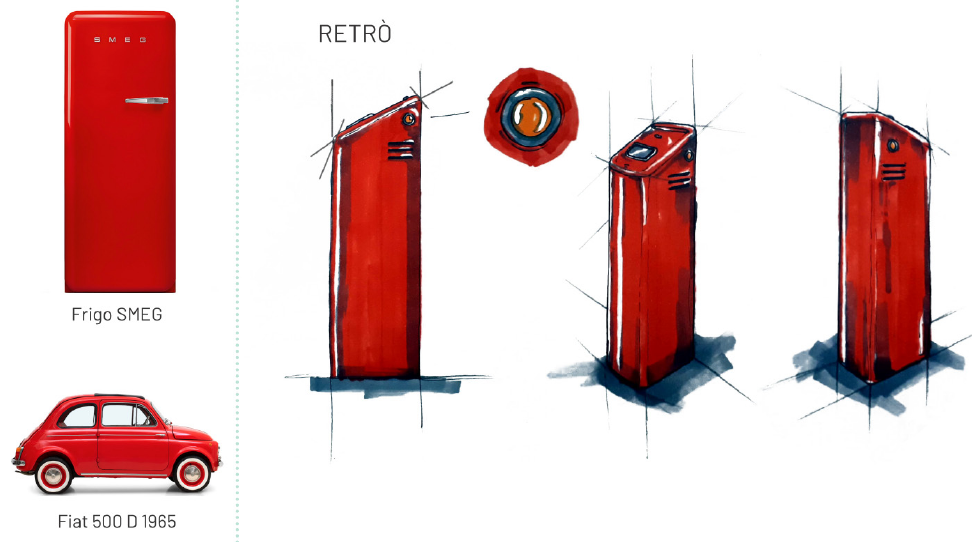
Figure 10. Retro style.